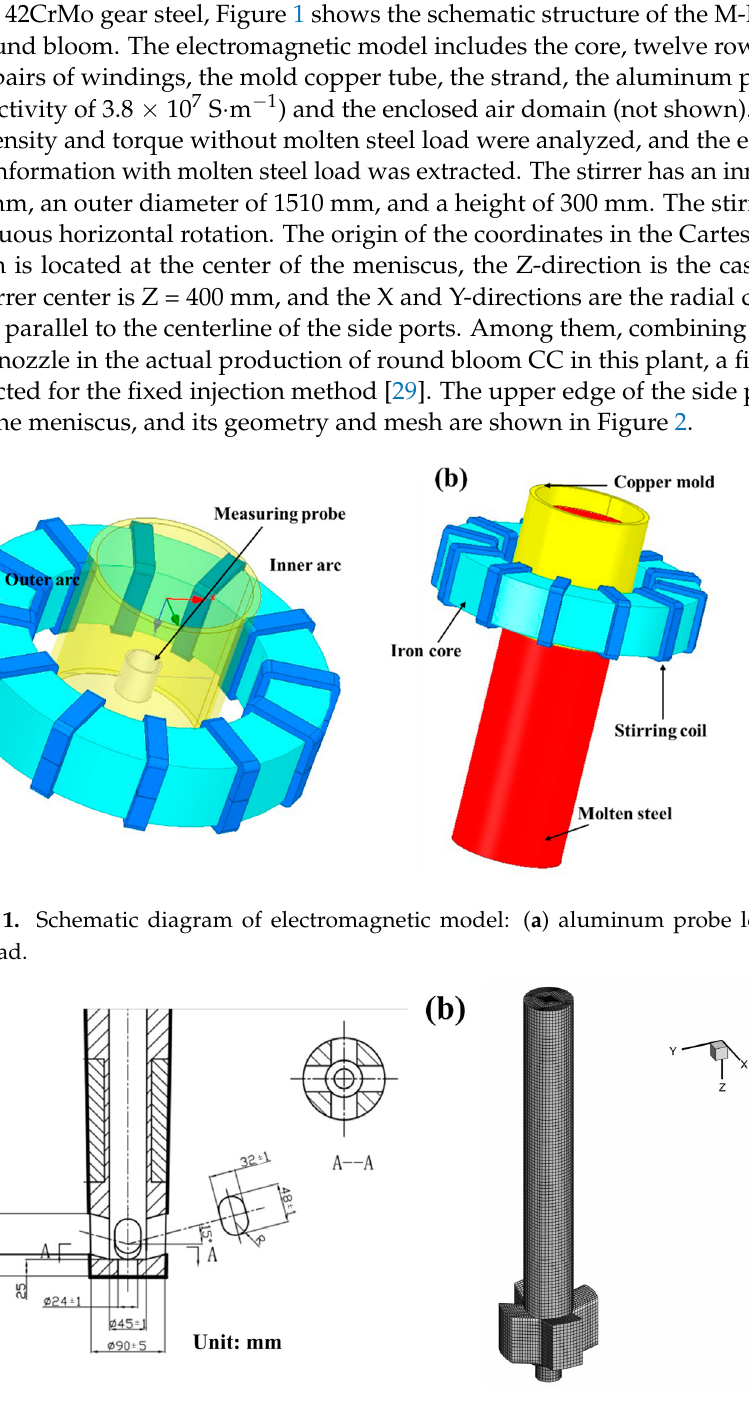
Figure 2. Schematic of the five-port nozzle: ( a ) geometry; ( b ) mesh.